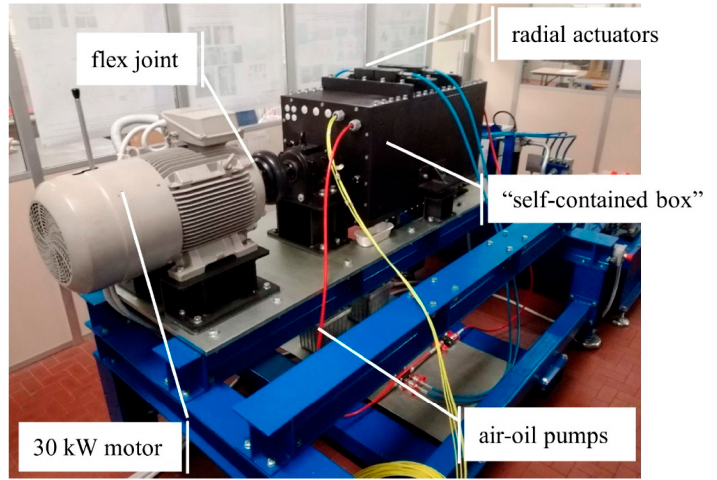
Figure 1. Test rig for industrial medium-sized bearings [80].